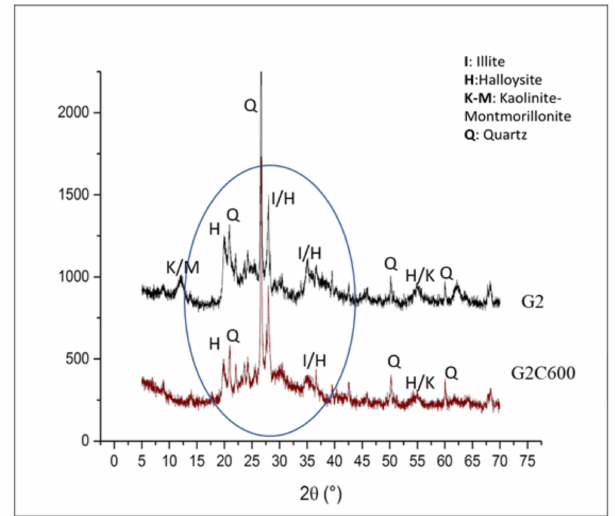
Figure 7. XRD patterns of G2 and